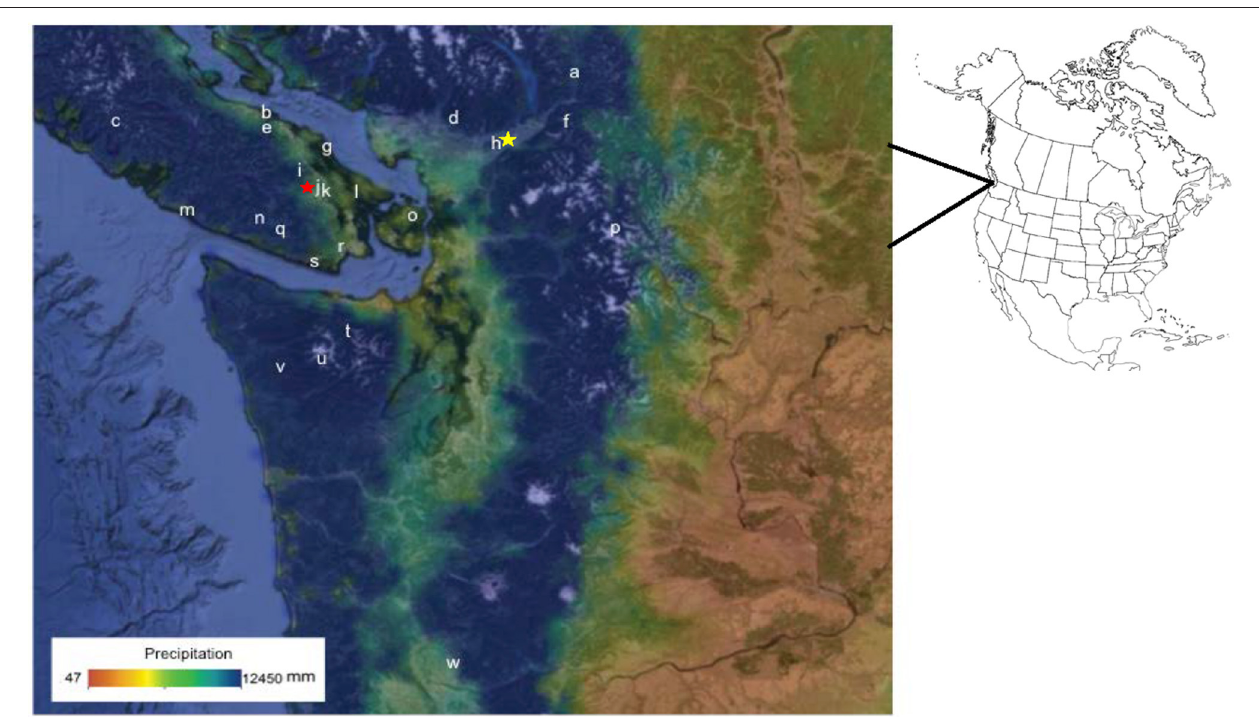
FIGURE 1 | Map of the Strait of Georgia Lowlands in western North America showing Somenos Lake (j and red star) on Vancouver Island and Chadsey Lake (h and yellow star) in the Fraser Valley. Location of study area in relation to inset map of North America Study sites include: (a) Frozen Lake (Hallett et al., 2003); (b) Enos Lake ( Brown and Hebda, 2002a); (c) Clayoquot Lake (Gavin et al., 2003); (d) Marion Lake (Wainman and Mathewes, 1987); (e) Boomerang Lake (Brown and Hebda, 2002a); (f) Mt. Barr Cirque Lake (Hallett et al., 2003); (g) Valdes Island On-site (i.e., Shingle Point) and Off-site Bogs; (Derr, 2014) (h) Chadsey Lake (this study); (i) Porphyry Lake (Brown and Hebda, 2003); (j) Somenos Lake (this study); (k) Quamichan Lake (Pellatt et al., 2015); (l) Roe Lake (Lucas and Lacourse, 2013; Pellatt et al., 2015); (m) Whyac Lake (Brown and Hebda, 2002b); (n) Pixie Lake (Brown and Hebda, 2002b); (o) Mount Constitution Small Hollow sites (Sugimura et al., 2008); (p) Panther Potholes (Prichard et al., 2009); (q) Walker Lake (Brown and Hebda, 2003); (r) Florence Lake (Pellatt et al., 2015); (s) East Sooke Fen (Brown and Hebda, 2002b ); (t) Moose Lake (Gavin et al., 2001); (u) Martins Lake (Gavin et al., 2001); (v) Yahoo Lake (Gavin et al., 2013); and (w) Battle Ground Lake (Walsh et al., 2008). Base layer is from Climate WNA (Wang et al., 2012) using PRISM precipitation data (Daly et al., 2002). Site locations available in S1 Supporting Information for Regional Study Sites